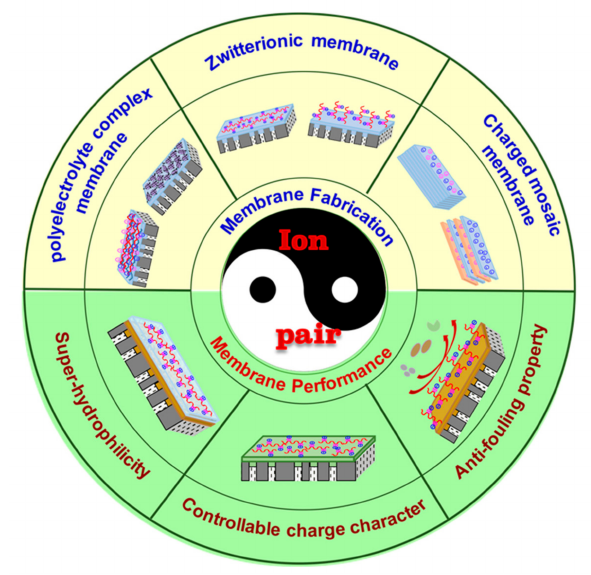
Figure 3. Overview of fabrication membranes containing ion pairs with improved permeability, selectivity, and antifouling